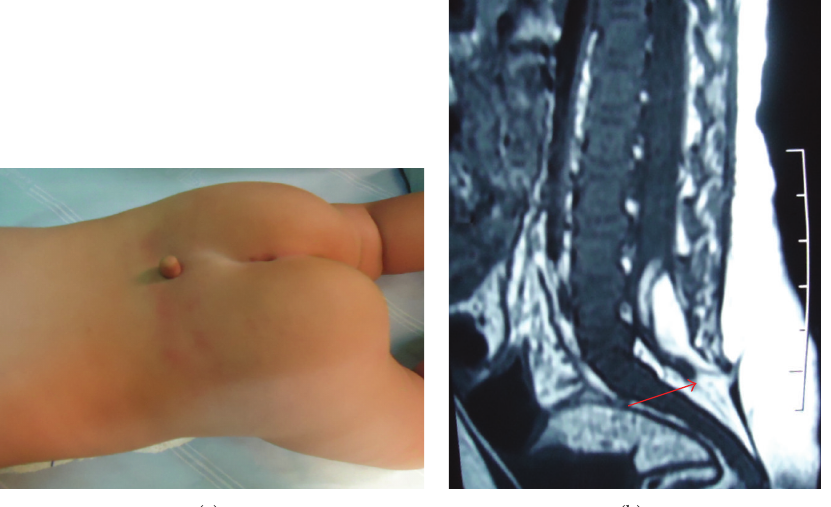
Figure 2: (a) Lesion at the lumbosacral region, type tail. (b) Confirmation by a lumbosacral MRI that showed a spinal dysraphism associated with intradural